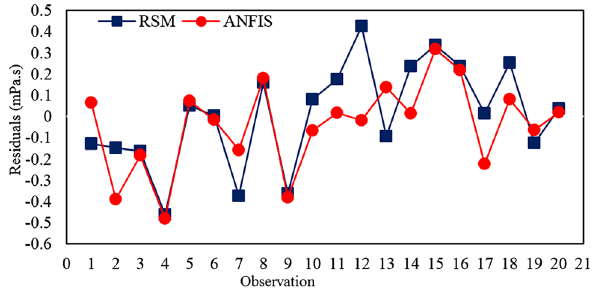
Fig. 6 Residuals of RMS and ANFIS models